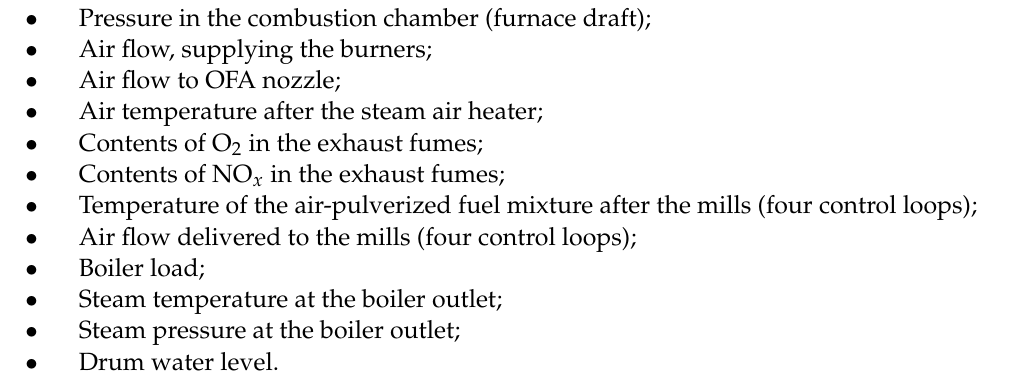
Table 1. Reasons for shutdown of power generating units in the consecutive years. Reason of the Block Shutdown—Year: